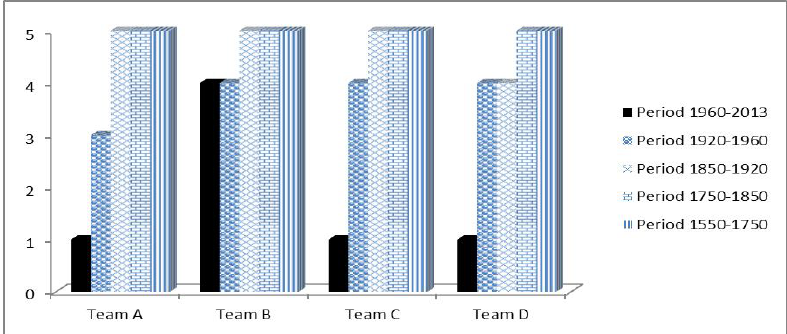
Figure 4 “Effects in present times” progression of ideas in each team for each